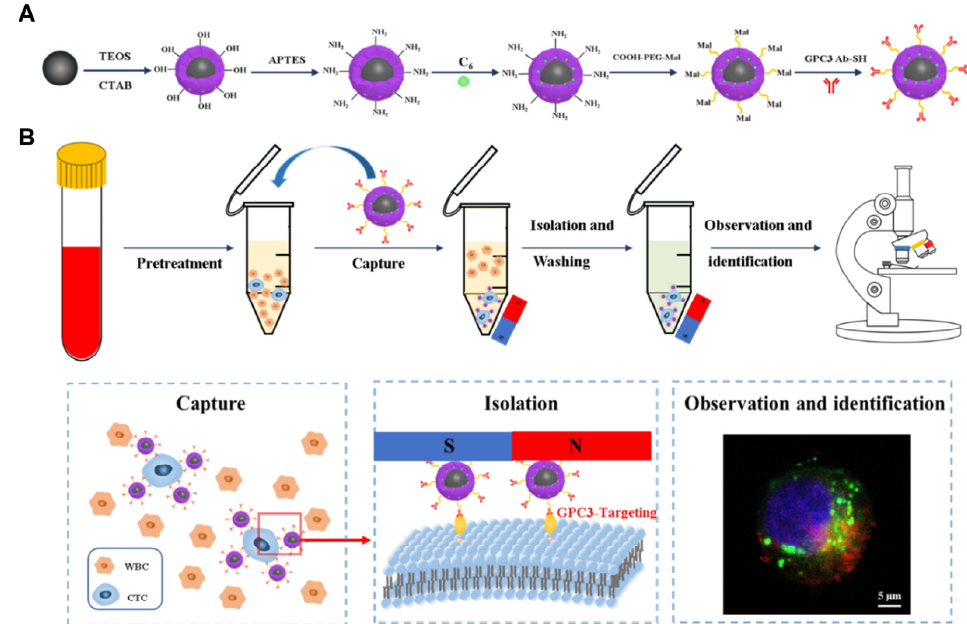
Figure 6. A method for highly specific capture, isolation and observation of hepatocellular carcinoma CTCs by immunomagnetic fluorescence nanodevices targeting GPC3. ( A ) The synthesis of immunomagnetic fluorescence nanodevices. ( B ) The capture principle of CTCs with immunomagnetic fluorescence nanodevices. The figure shows the synthesis process of nanoparticles and the capture and recognition process of CTCs. Reprinted with permission from Ref. [30]. Copyright 2021 Dovepress.